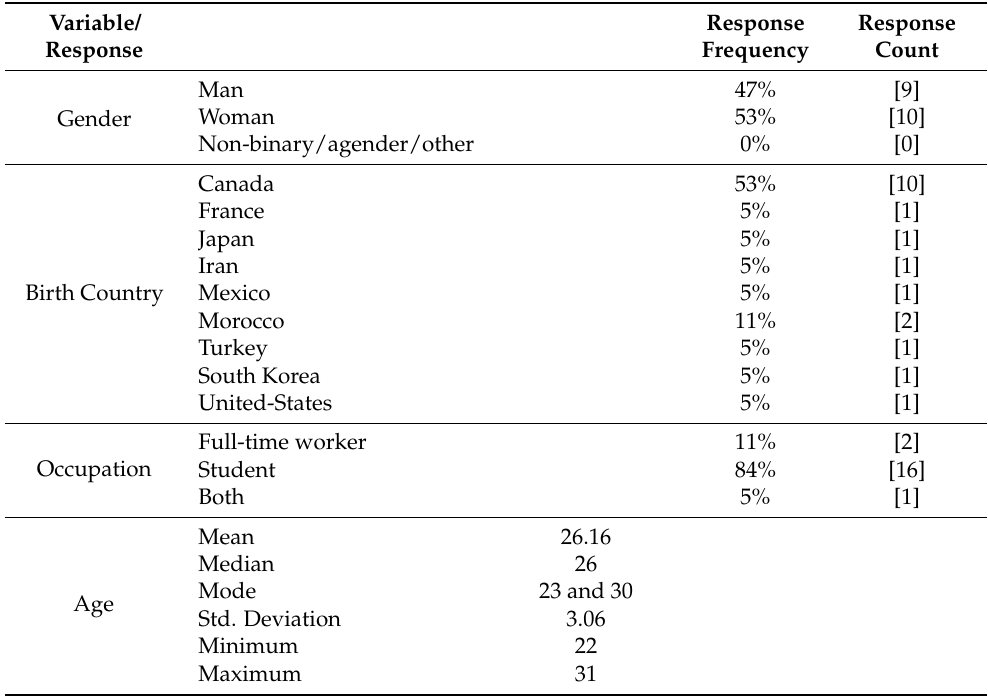
Table 5. Participant Demographics (N =